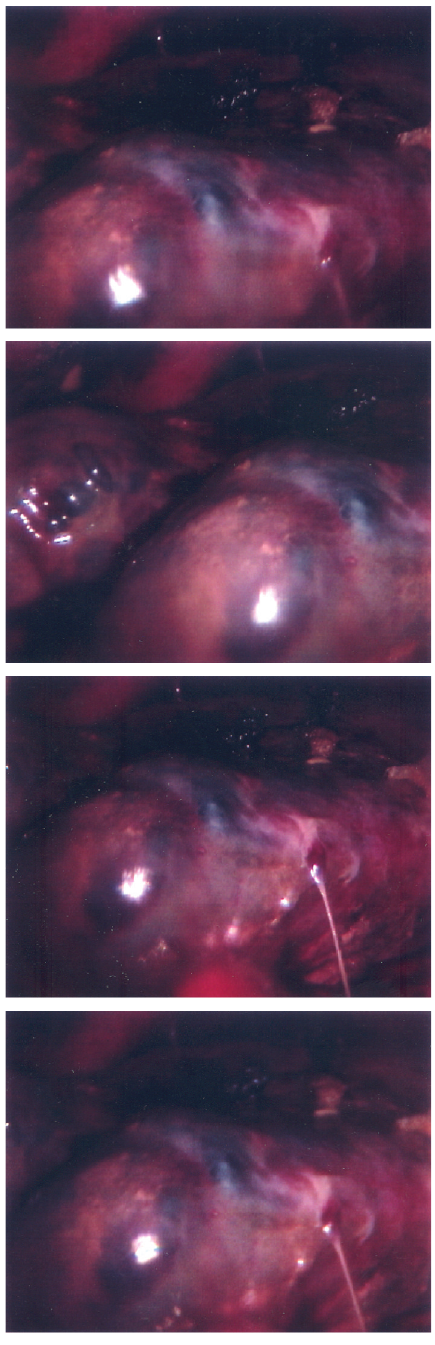
Figure 2: Intraoperative color photograph demonstrating the lobu- lated blood filled cystic mass consistent with hepatic